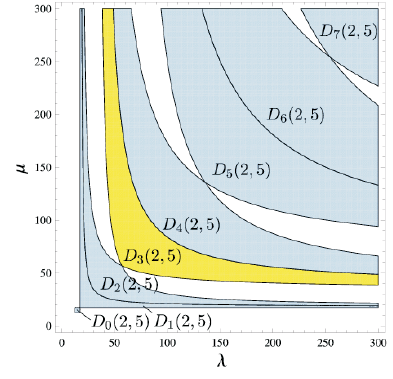
Figure 5. “Good” regions D j (2 , 5) ( j = 0 , 1 ,..., 7)